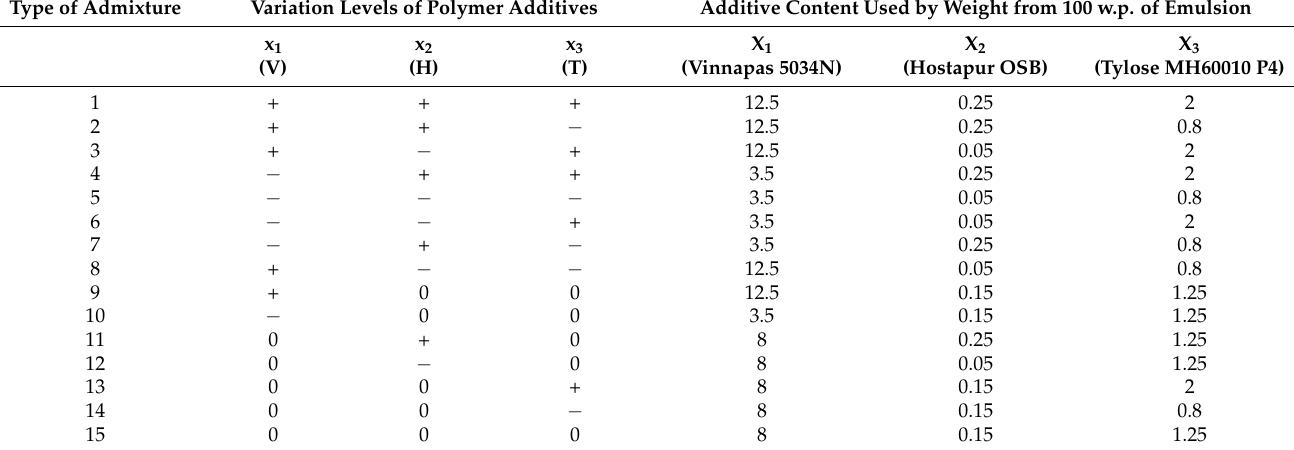
Table 2. Experimental plan.